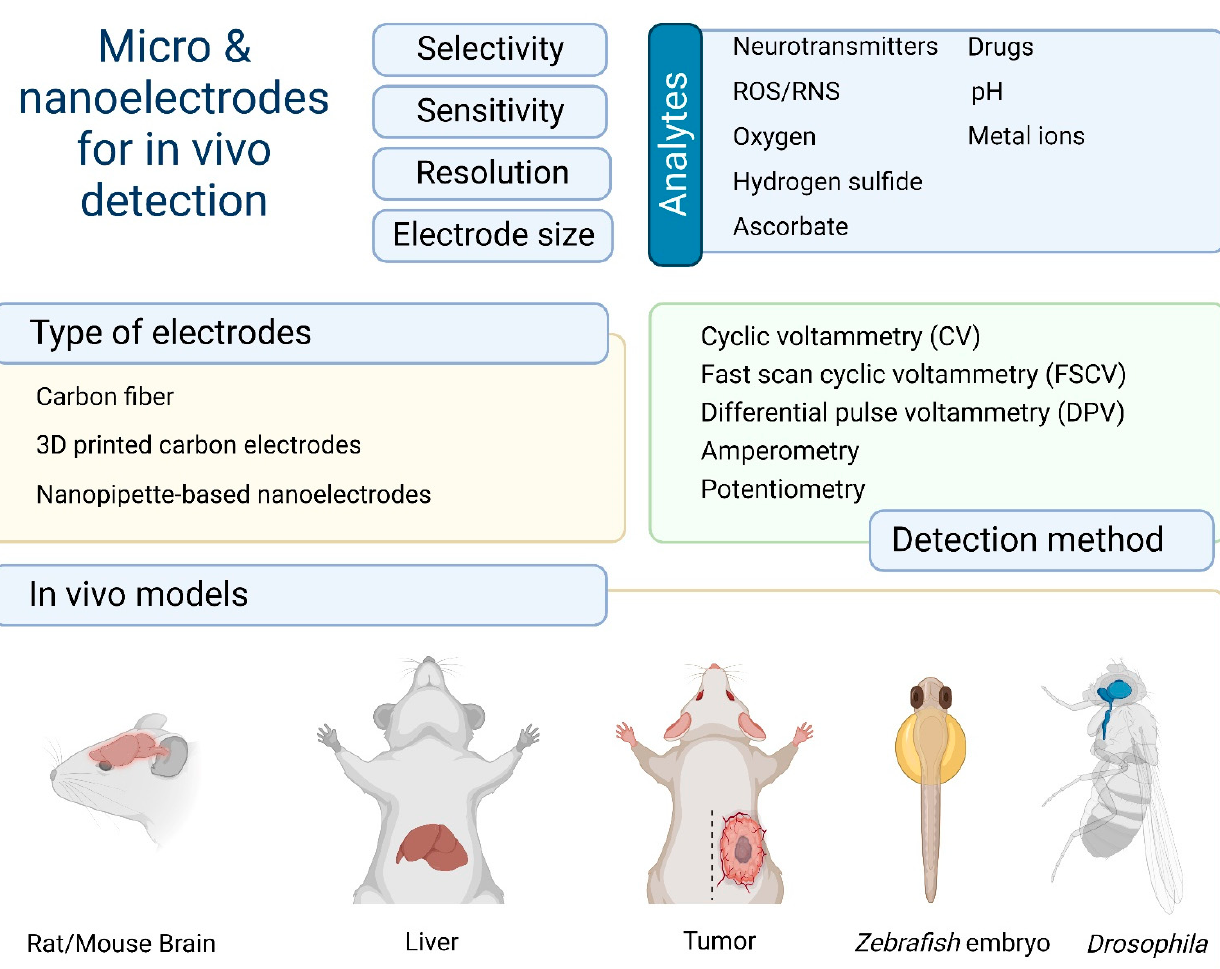
Figure 1. Brief summary of the types of analytes, electrodes, detection methods, and in vivo models for electrochemical detection.